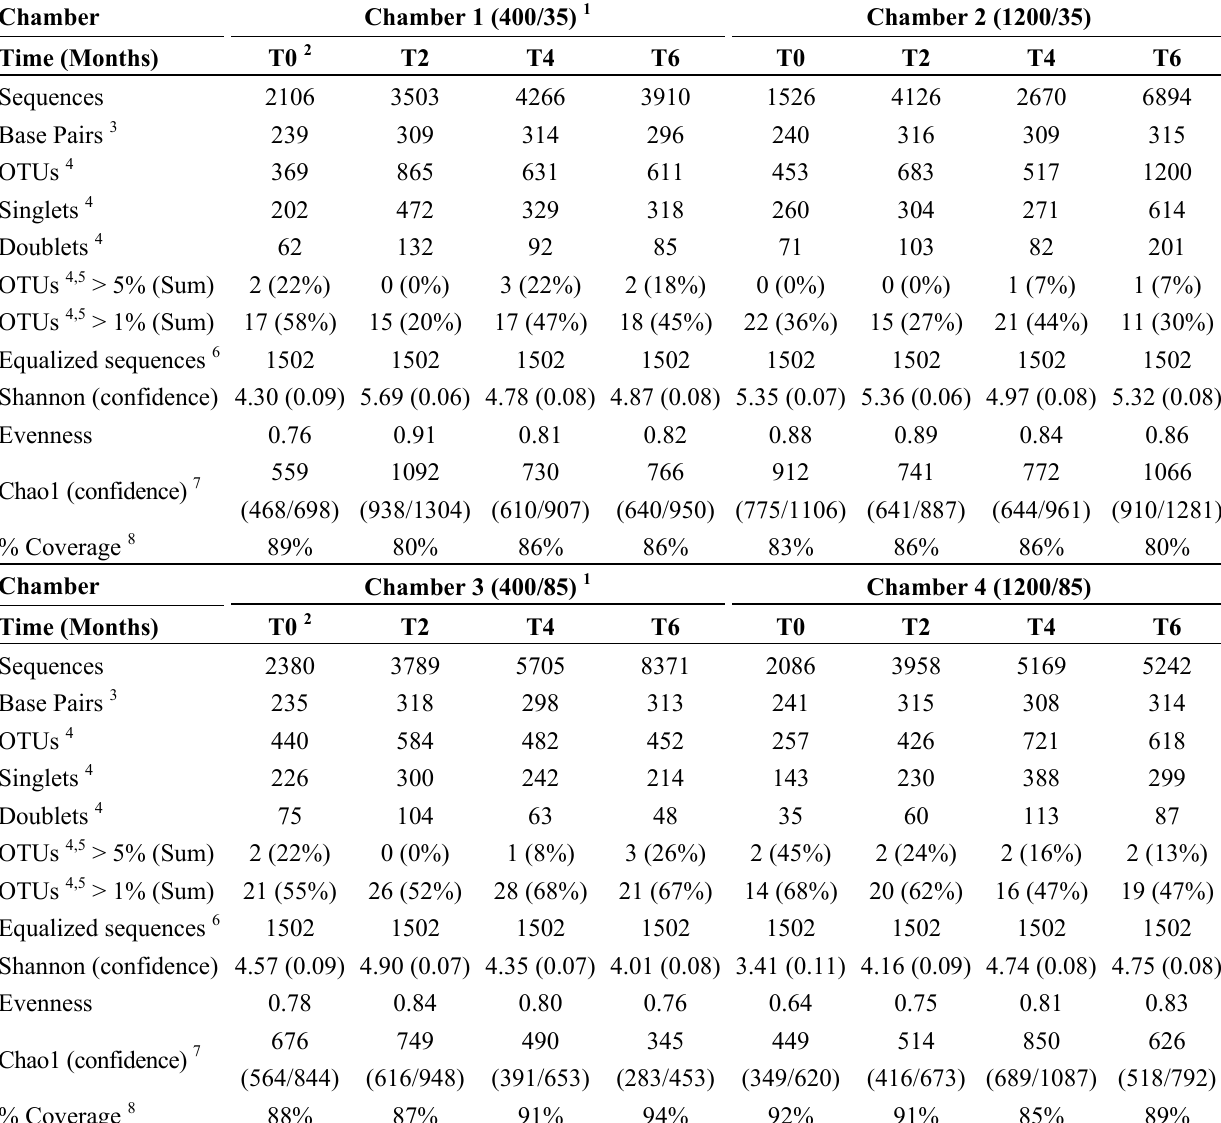
Table 2. Alpha diversity measures for 16S rRNA gene amplicon library from microbialites exposed to variable CO and salinity 2